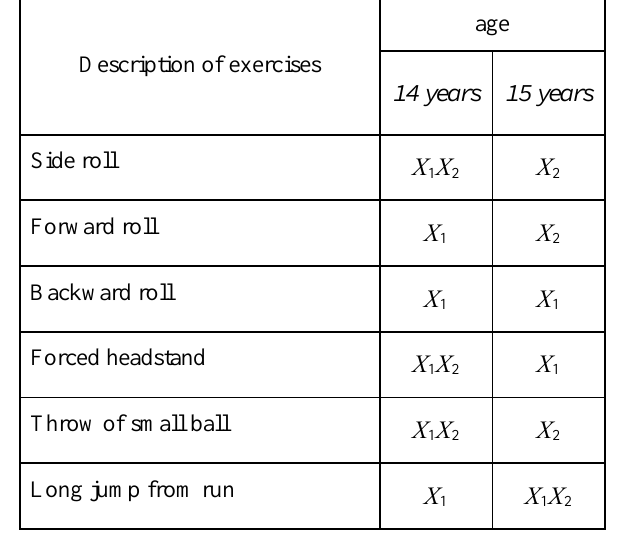
Comparative characteristic of studied factors’ influence on effectiveness of 14-15 years’ old girls’